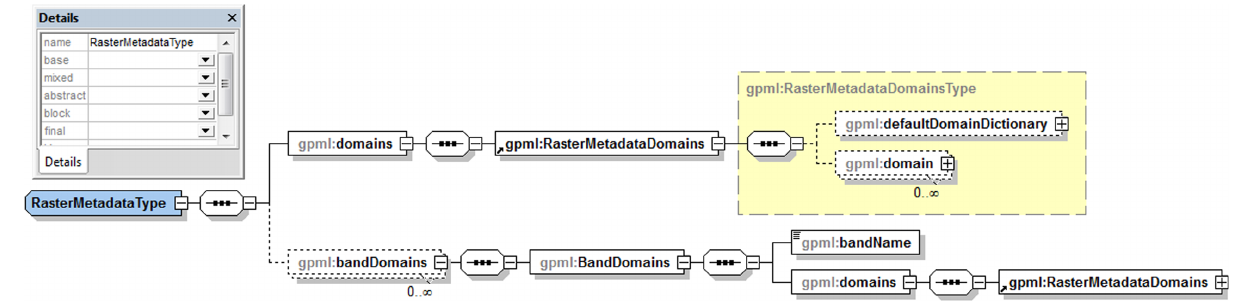
Fig. 28. Schema diagram for raster